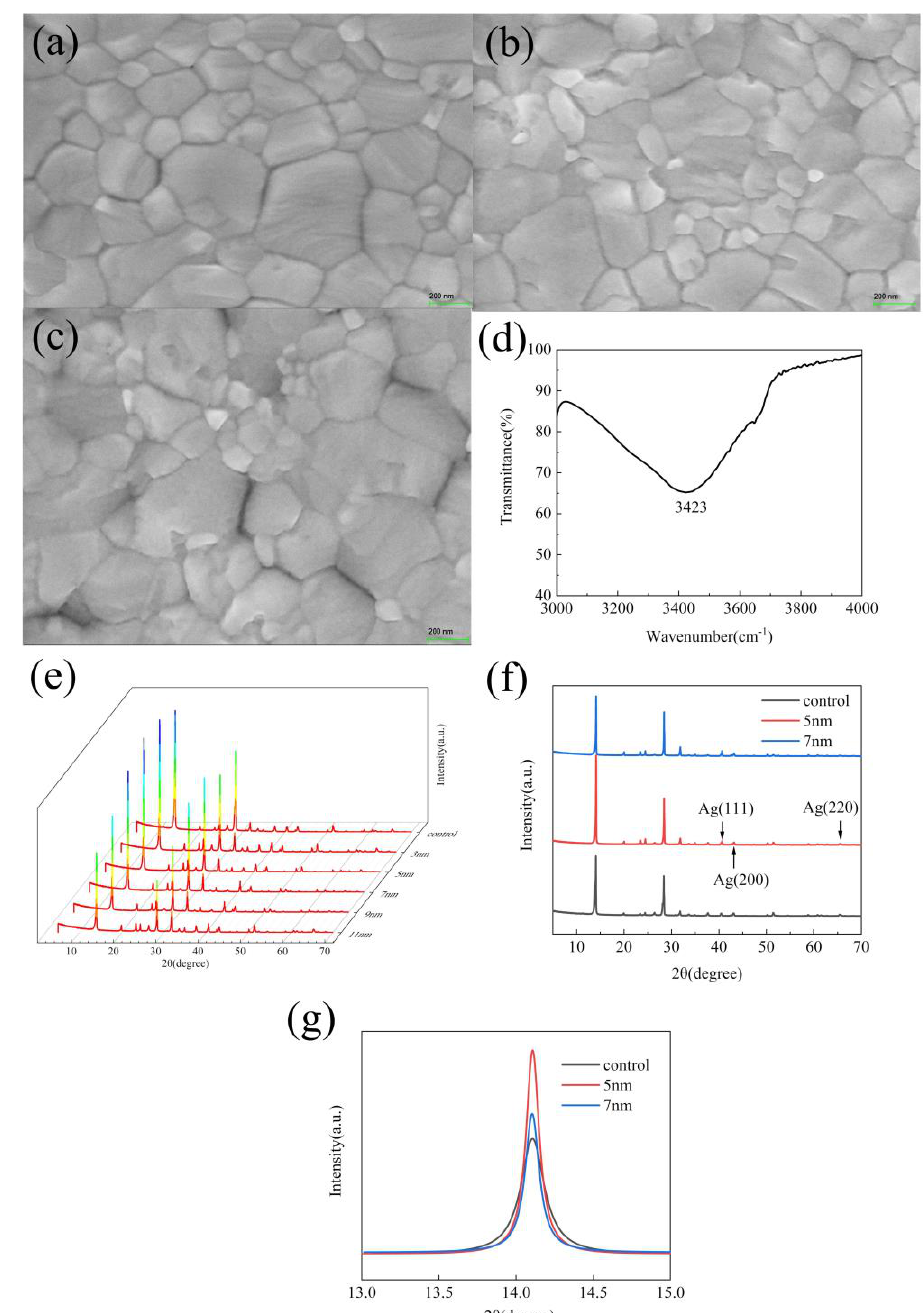
Figure 4. SEM images of ( a ) pristine CH 3 NH 3 PbI 3 film. ( b ) CH 3 NH 3 PbI 3 films with a 5-nm shell thickness of Ag@SiO 2 core-shell nanoparticles. ( c ) CH 3 NH 3 PbI 3 films with an 11-nm shell thickness of Ag@SiO 2 core-shell nanoparticles. ( d ) Fourier Transform Infrared Spectrometer of nanoparticles. ( e ) XRD patterns of the pristine CH 3 NH 3 PbI 3 film and CH 3 NH 3 PbI 3 films with 3 nm, 5 nm, 7 nm, 9 nm, and 11 nm shell thickness of Ag@SiO 2 core-shell nanoparticles. ( f ) XRD patterns of the pristine CH 3 NH 3 PbI 3 film, CH 3 NH 3 PbI 3 films with a 5-nm shell thickness Ag@SiO 2 core-shell nanoparticles, and CH 3 NH 3 PbI 3 films with a 7-nm shell thickness of Ag@SiO 2 core-shell nanoparticles. ( g ) XRD patterns of detailed view of the (110) diffraction peak ranging from 13° to 14°.